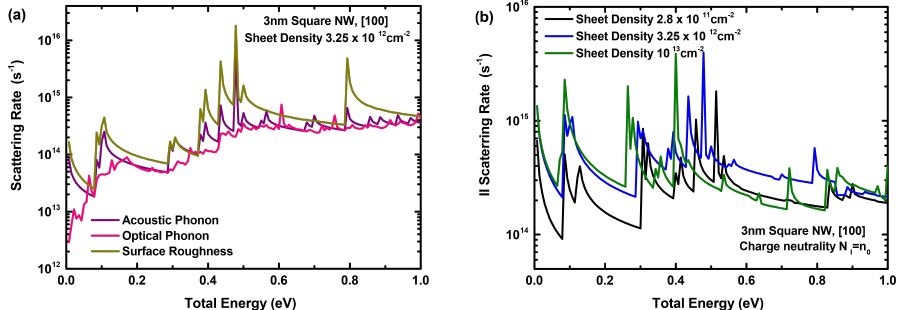
Figure 3. ( a ) The rates for acoustic and optical phonons, as well as surface roughness scattering as a function of the total energy, for a sheet density of 3.25 × 10 12 cm − 2 . ( b ) The rates for ionized impurity scattering, as a function of the total energy and different sheet densities, assuming charge neutrality. The results are for a 3 nm diameter square nanowire structure.